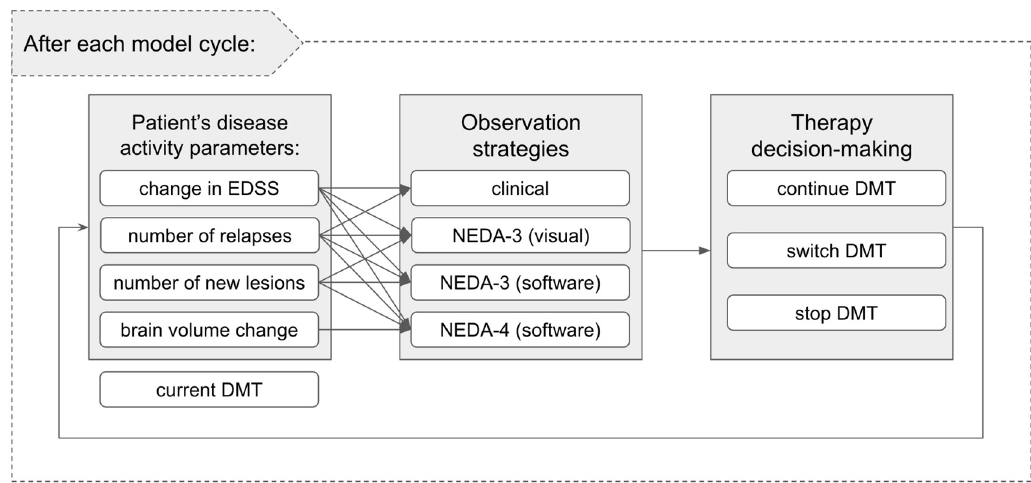
Figure 2. Schematic representation of the interaction between the hidden patient state, defined by the disease activity parameters, the considered observation strategies, and the therapy decision-making options after each model cycle.